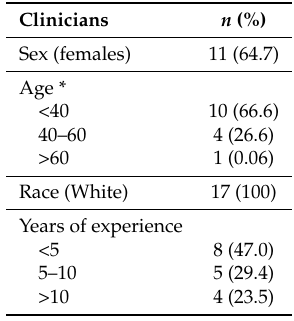
Table 3. Demographic characteristics of clinicians interviewed ( n = 17).